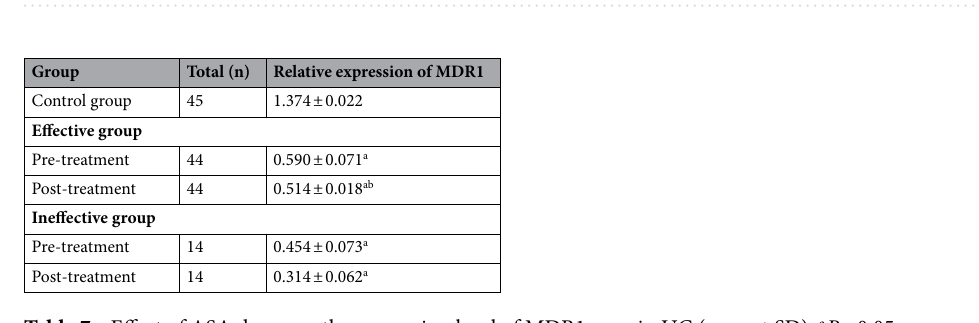
Table 7. Effect of ASA drugs on the expression level of MDR1 gene in UC (mean ± SD). a P < 0.05 versus normal control. b P > 0.05 versus pre-treatment.